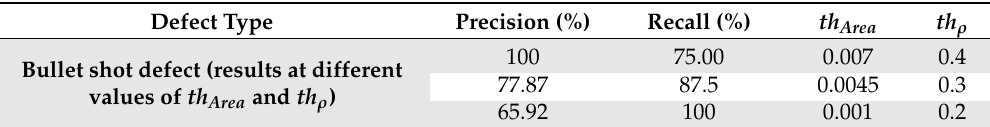
Table 4. Performance results of the defect analyzer.